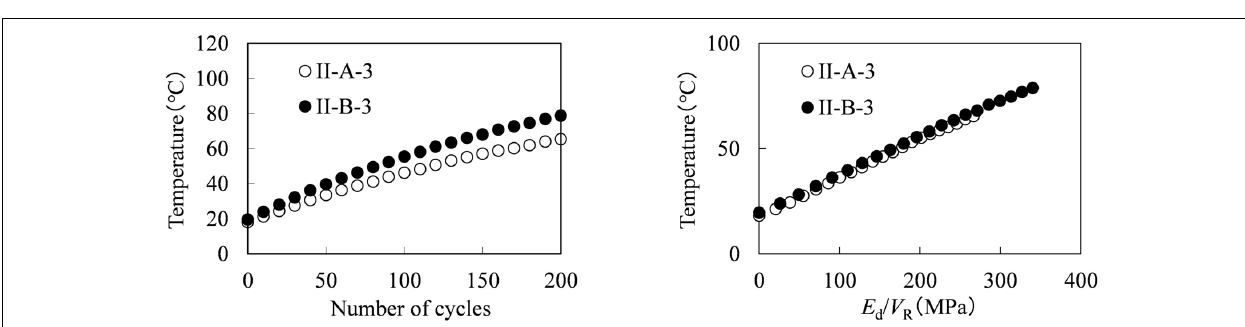
FIGURE 11 | Change of temperature by increase of loading cycle and E d / V r in scale-II-A, and